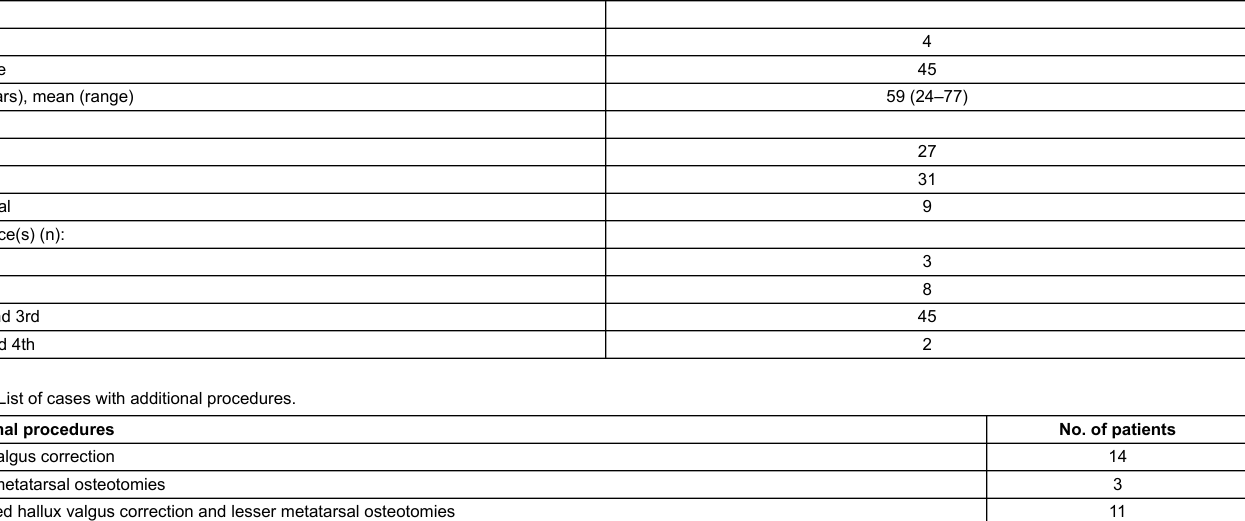
Table 1: Demographics.